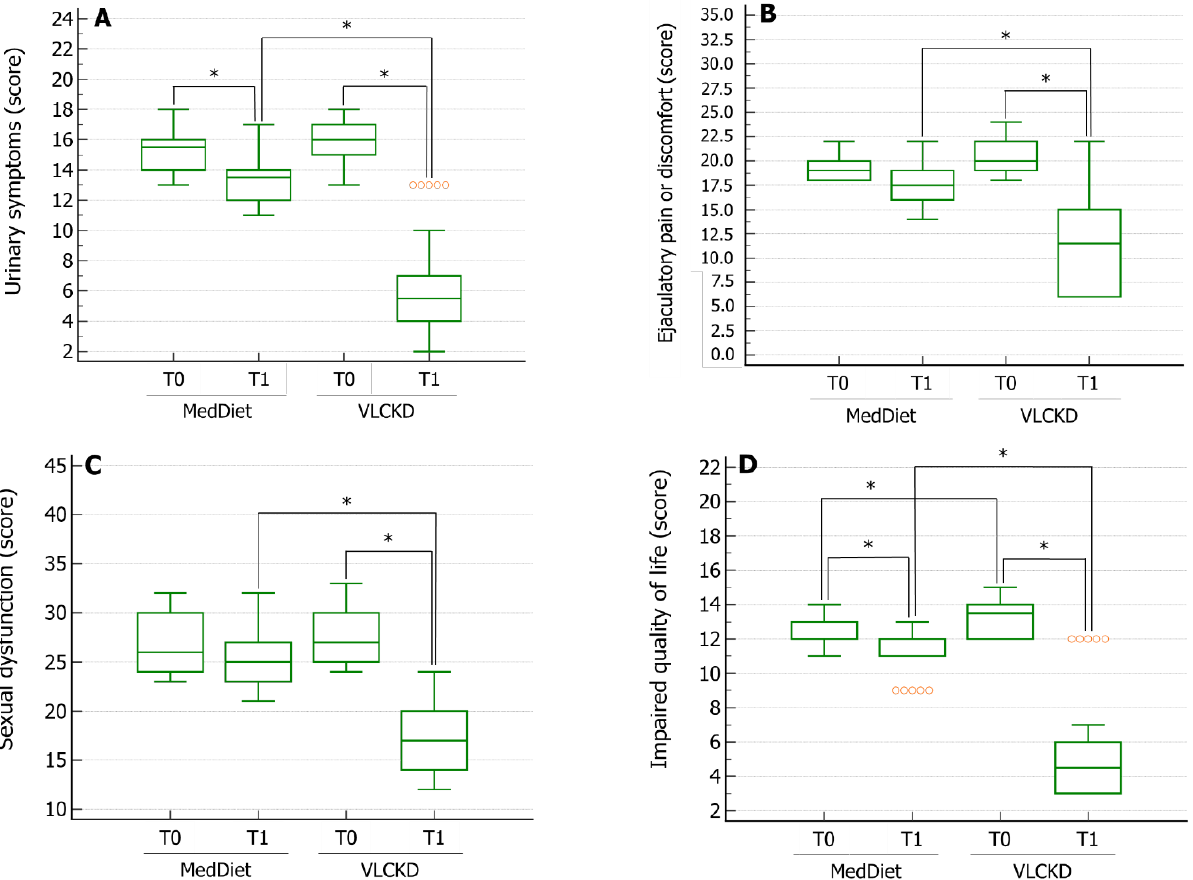
Figure 2. Scores were obtained by administering the Structured Interview on Male Accessory Gland Inflammation (MAGI) on urinary symptoms (Panel A ), ejaculatory pain or discomfort (Panel B ), sexual dysfunction (Panel C ), and impaired quality of life (Panel D ) in patients with MAGI before (T0) and after three months (T1) on a Mediterranean diet (MedDiet) or very-low-calorie ketogenic diet (VLCKD). * p < 0.05 by one-way analysis of variance followed by the Tukey–Kramer post hoc test.